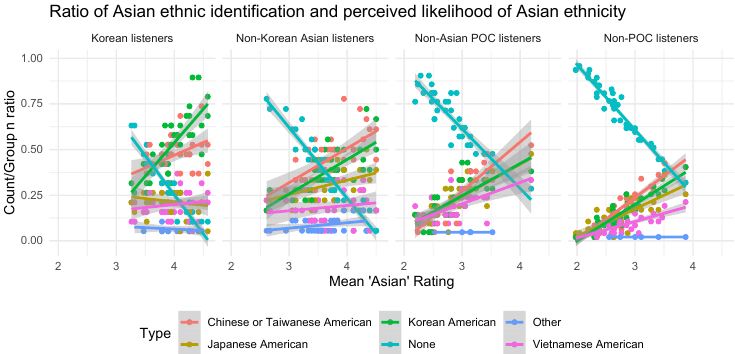
Figure 7. Ratio of the number of times each ethnicity was chosen to the total number of choices made for each speaker, by speaker’s mean Asian rating, split by listener’s racial/ethnic category (Korean n = 19, non-Korean Asian n = 18, non-Asian POC n = 24, White n = 44). Korean listeners were most likely to identify Asian American speakers as specifically Korean American, while the other three listener groups tended to choose Korean and Chinese or Taiwanese with equal